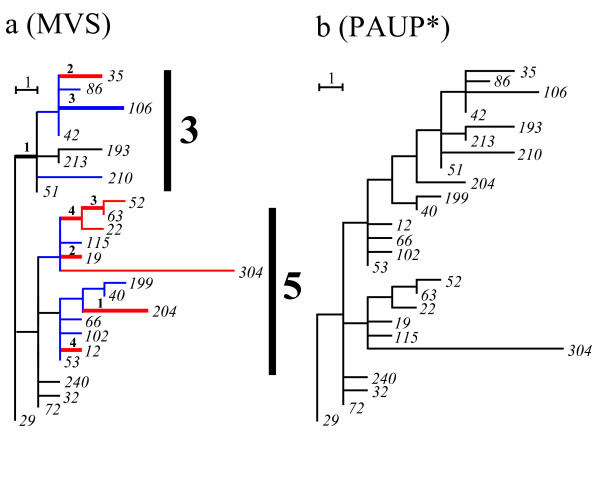
Core set tree compared to MP tree. We considered the 25 haplotypes of groups 3 and 5 in Fig. 4a. PAUP* yielded 15 different branch patterns on the maximum parsimony criterion. One of them gave the same result as the core set approach (Fig. 5a), while another of them gave a very different pattern from our result (Fig. 5b). The bold lines indicated by block letters in Fig. 5a denote parallel changes of four pairs.